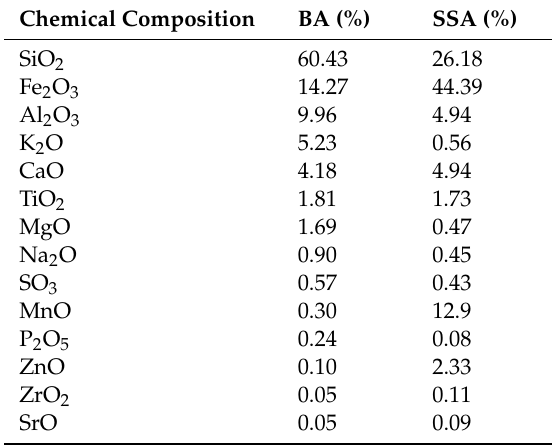
Table 1. Chemical composition of brick and induction furnace steel slag.